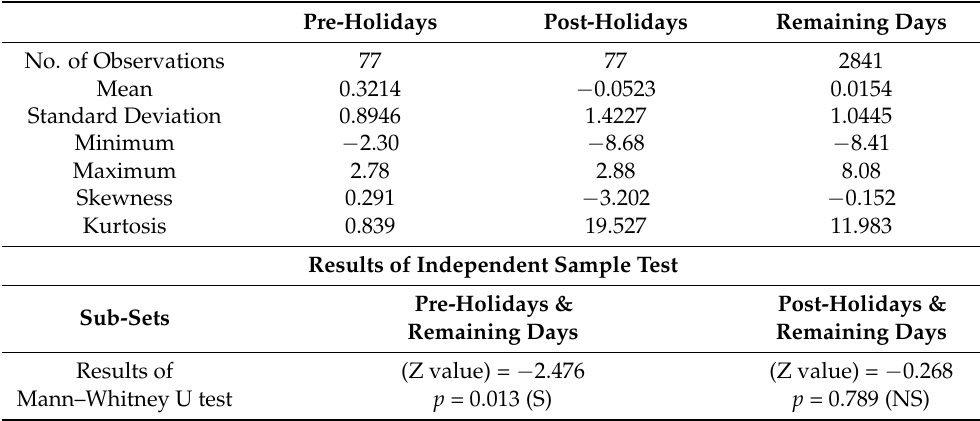
Table 3. The Results of Descriptive Statistics for ADSMI Daily Returns for Pre, Post-Holiday and